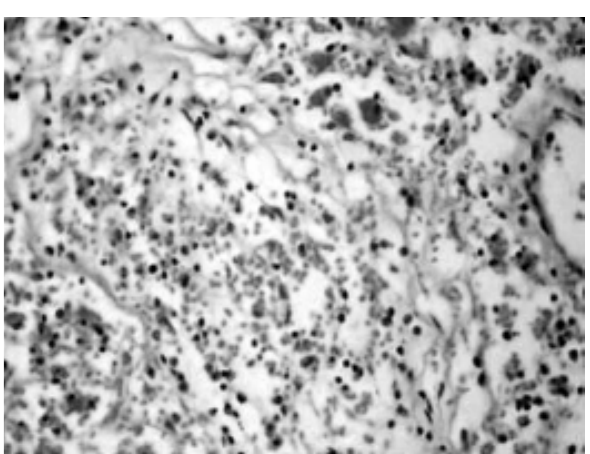
Fig. 2b - Hemangioma - Aspecto microscópico